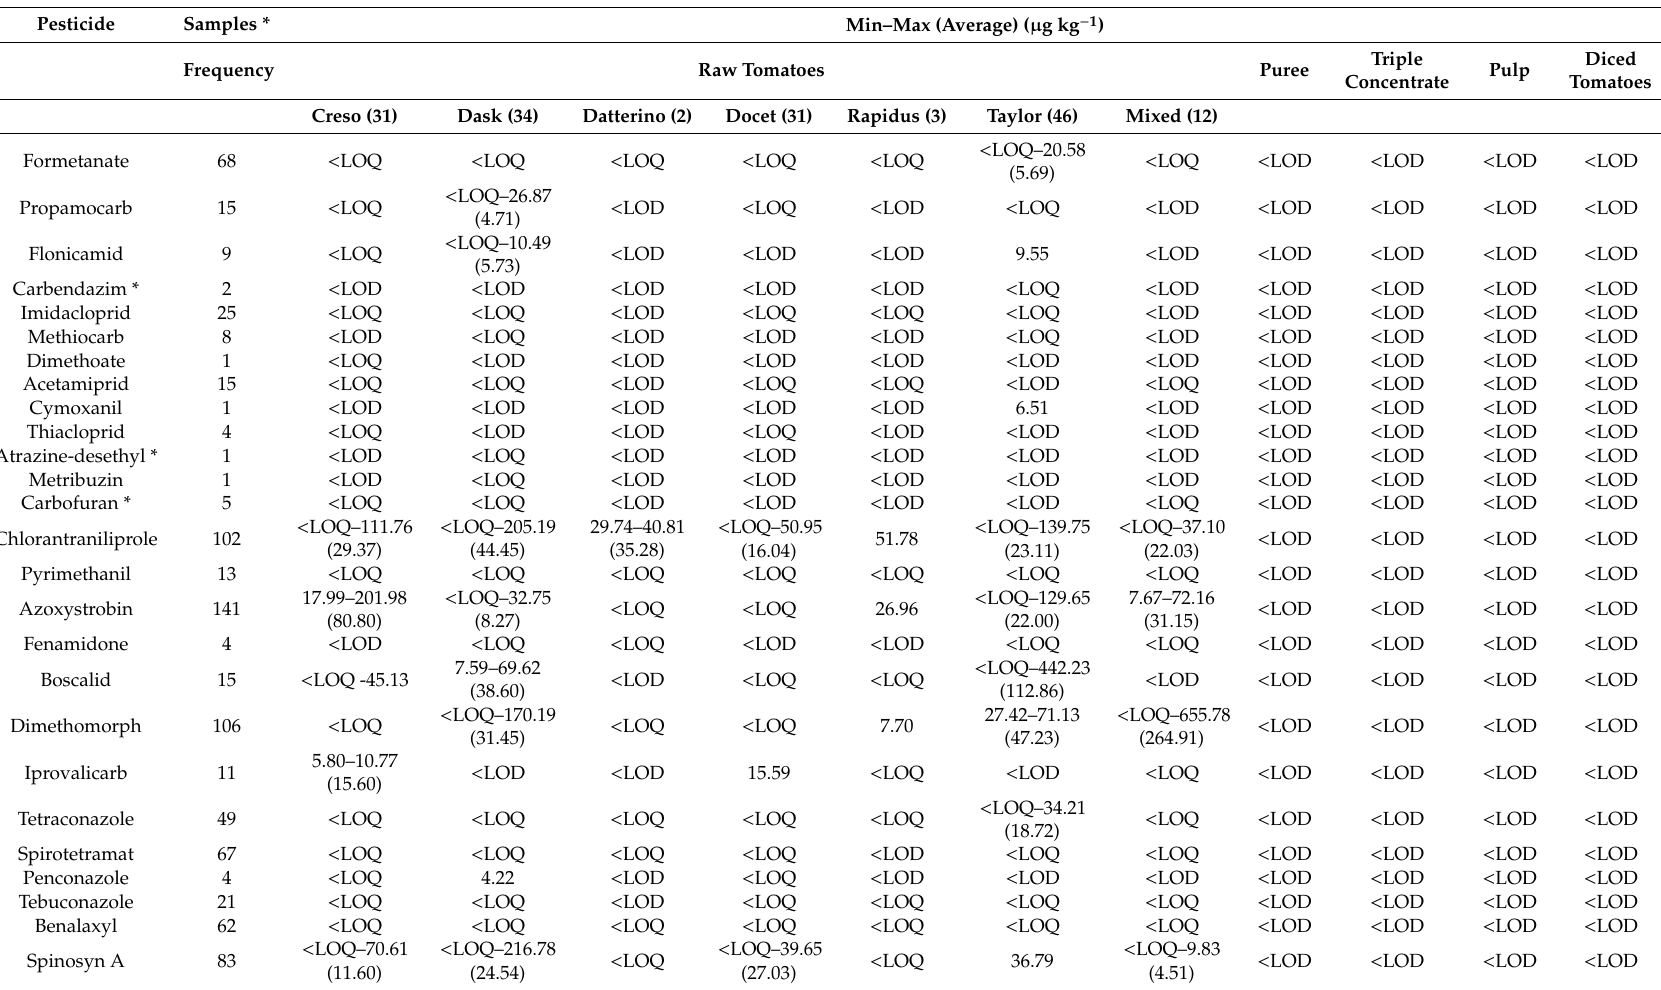
Table 2. Pesticide residues concentration (minimum and maximum µ g / kg) in raw tomatoes and processed products analyzed during the survey.